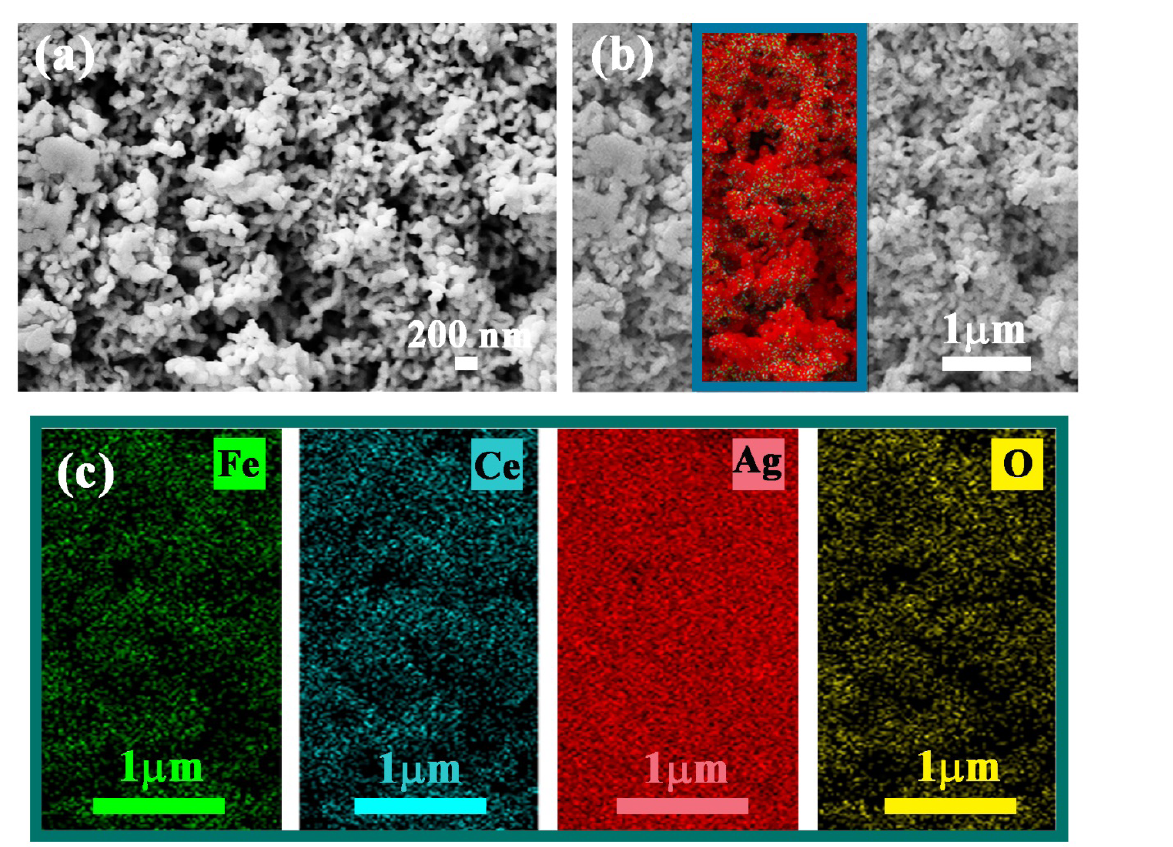
Figure 3. The results obtained from Field Emission Scanning Electron Microscopy (FESEM) A: FESEM image; B: FESEM map image; and C: The corresponding elemental mappings for Fe